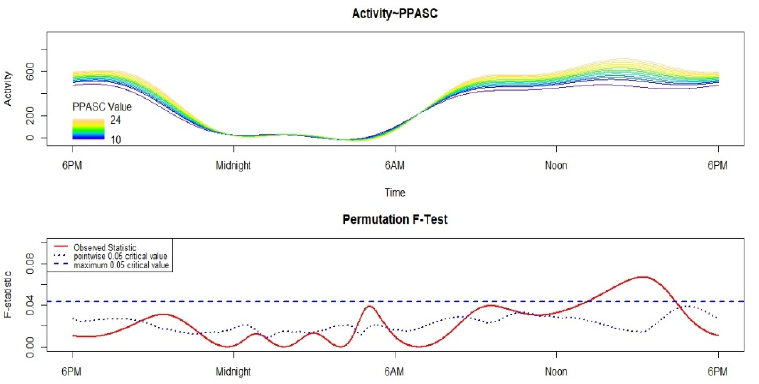
Figure 1. Results of the Functional Linear Modeling applied to the analysis of the variation in the 24 h motor activity pattern according to the total score of the Perceived Physical Ability Scale for Children (PPASC). The upper panel shows the circadian activity rhythm plotted according to PPASC, with different colors depicting the circadian activity rhythm of participants with different PPASC total scores. Blue indicates the lowest total score of the PPASC, while dark yellow refers to the highest. The lower panel shows the results of the non-parametric permutation F-test. Significant differences can be detected when the solid red line is above the dotted blue line (i.e., the point-wise test of significance) or the dashed blue line (i.e., the global test of significance, more